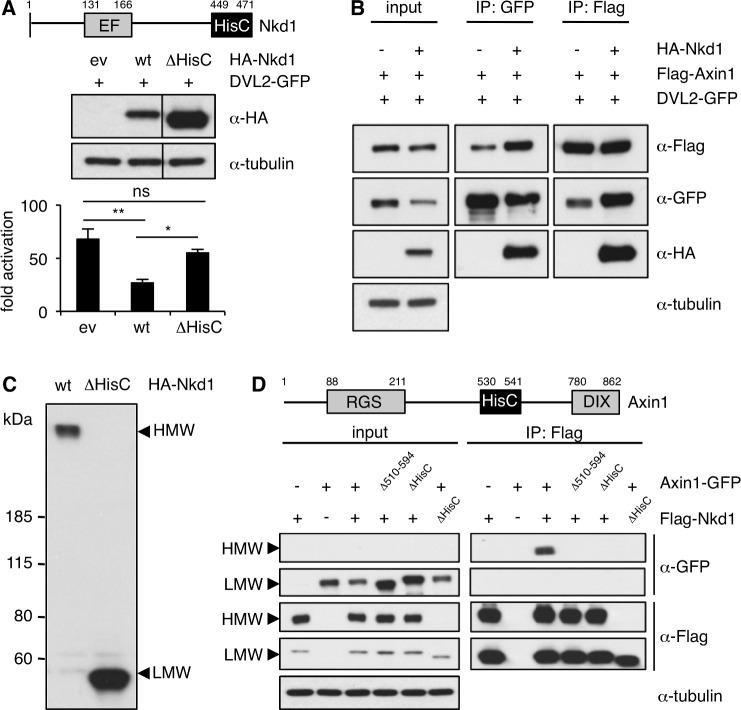
Nkd1 co-aggregates with Axin1 via highly conserved HisCs.(A) SuperTOP assays, monitoring the signaling activity of overexpressed DVL2-GFP upon co-expression with wt or ΔHisC HA-Nkd1 in transfected HEK293T cells (used in this and all subsequent figures unless otherwise stated); expression levels were monitored by Western blot (above); error bars, SEM of > 3 independent experiments; one-way ANOVA with multiple comparisons; *p < 0.05, **p < 0.01. (B) CoIP assays between co-expressed proteins, as indicated above panels. (C) Western blot of wt and ΔHisC HA-Nkd1, revealing HisC-dependent HMW aggregates; left, positions of molecular weight markers (LMW, corresponding to monomeric Nkd1); in subsequent figures, only HMW and LMW regions are shown (see also supplementary information, for full-length gels). (D) CoIP assays between co-expressed proteins, as indicated above panels, monitoring ΔHisC-dependent co-aggregation of Flag-Nkd1 and Axin1-GFP (note that the amounts of transfected DNA has been adjusted in this experiment, to obtain comparable expression levels of different constructs).